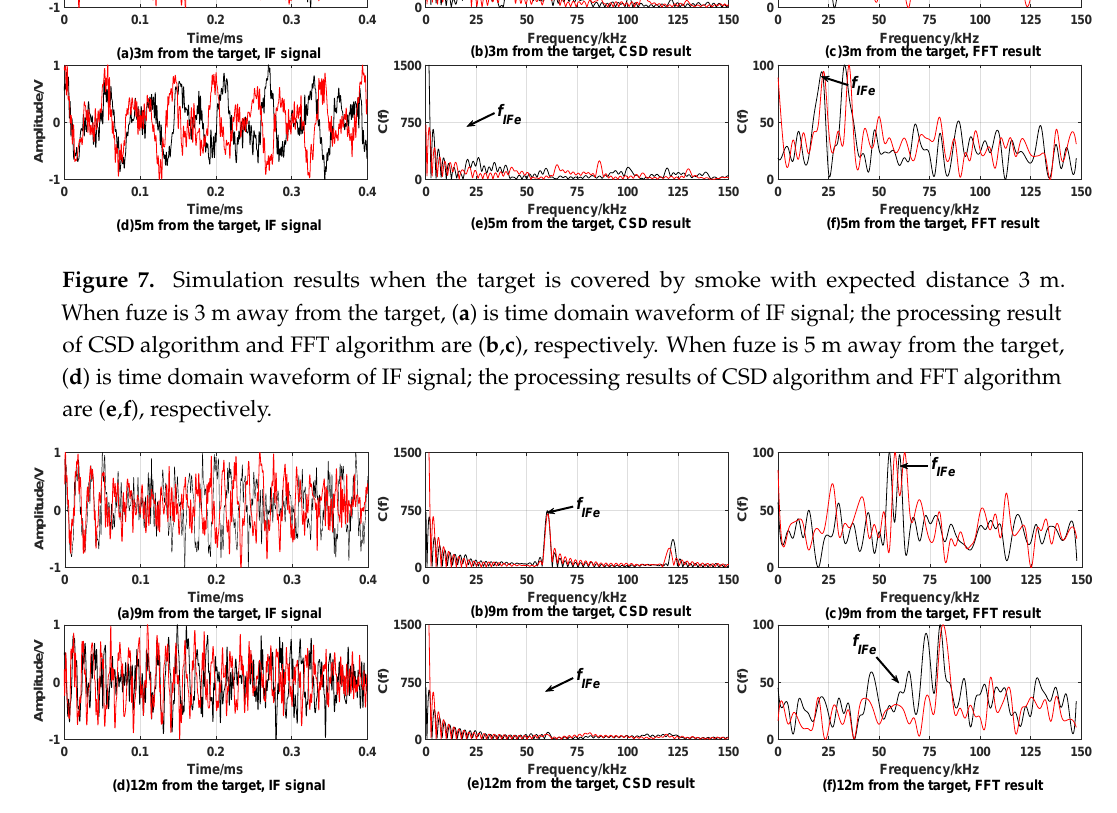
Figure 8. Simulation results when the target is covered by smoke with expected distance 9 m. When fuze is 9 m away from the target, ( a ) is time domain waveform of IF signal; the processing result of CSD algorithm and FFT algorithm are ( b , c ), respectively. When fuze is 12 m away from the target, ( d ) is time domain waveform of IF signal; the processing result of CSD algorithm and FFT algorithm are ( e , f ),